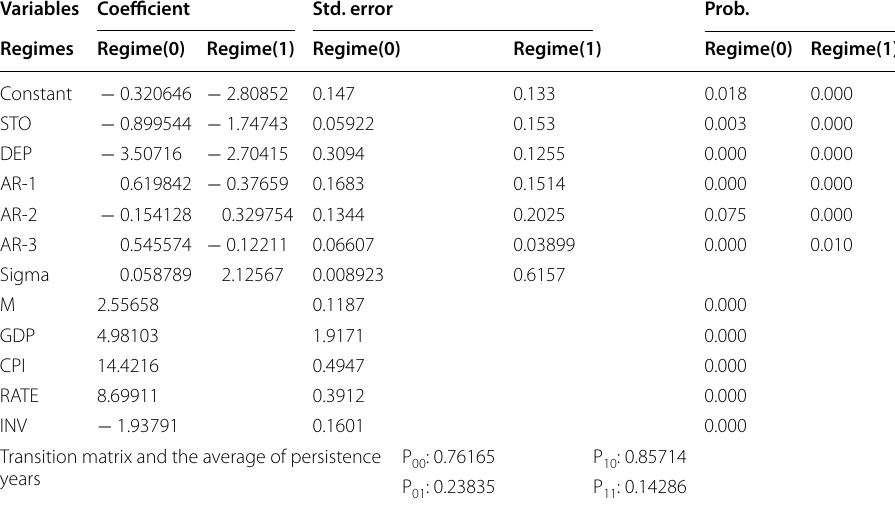
Table 7 The estimation results of equation